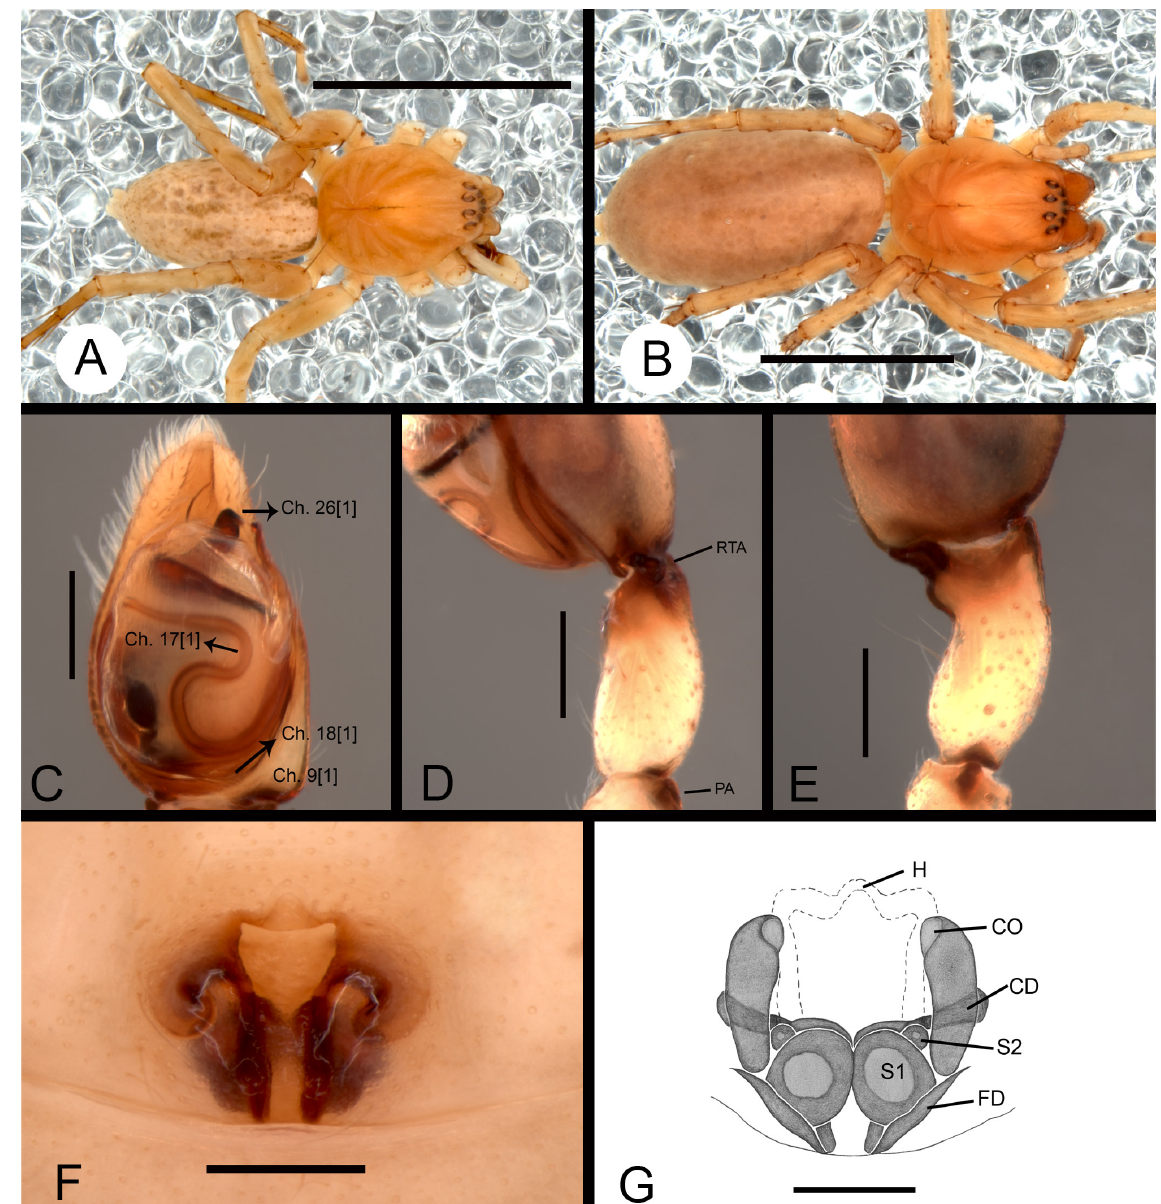
Fig. 25. Tafana maracay sp. nov. (A, C–E = ♂, MNHN 11314; B, F–G = ♀, MNHN 11314). A . Habitus, dorsal view. B . Habitus, dorsal view. C . Left palp, ventral view (arrow indicating character). D . Left palp, retrolateral view. E . Left palp, dorsal view. F . Epigynum, ventral view. G . Vulva, dorsal view. Abbreviations: CD = copulatory ducts; Ch = character; CO = copulatory opening; FD = fertilization ducts; H = hood; PA = patellar apophysis; RTA = retrolateral tibial apophysis; S1 = primary spermathecae; S2 = secondary spermathecae. Scale bars: A = 2.16 mm; B = 3.5 mm; C–G = 0.25